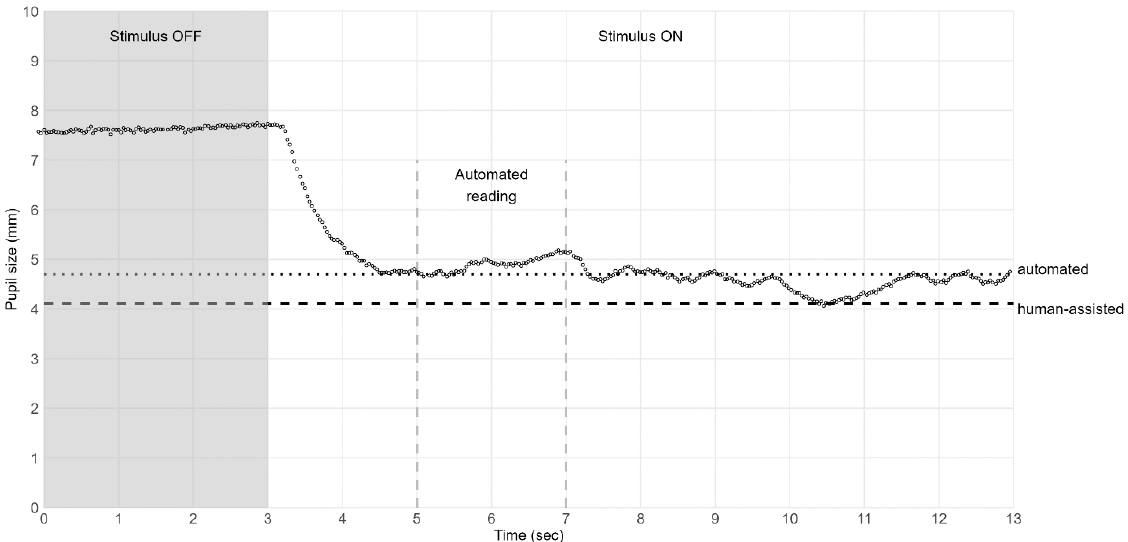
Figure 2. Difference between reading methods include the influence of latent pupillary constriction. Notes: An example of latent pupillary constriction resulting in a deviation between reading methods. Pupil size is continuously recorded during 3 s of darkness (Stimulus OFF) and 10 s of light (Stimulus ON). The pupil constricts from about 7.7 mm to about 4.7 mm (3 to 5.5 s), escapes to larger size (5.5